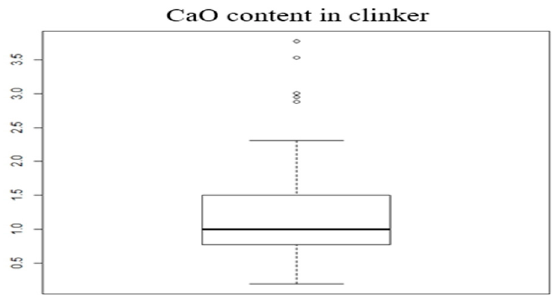
Figure 6. CaO F content in clinker. Source: own source.